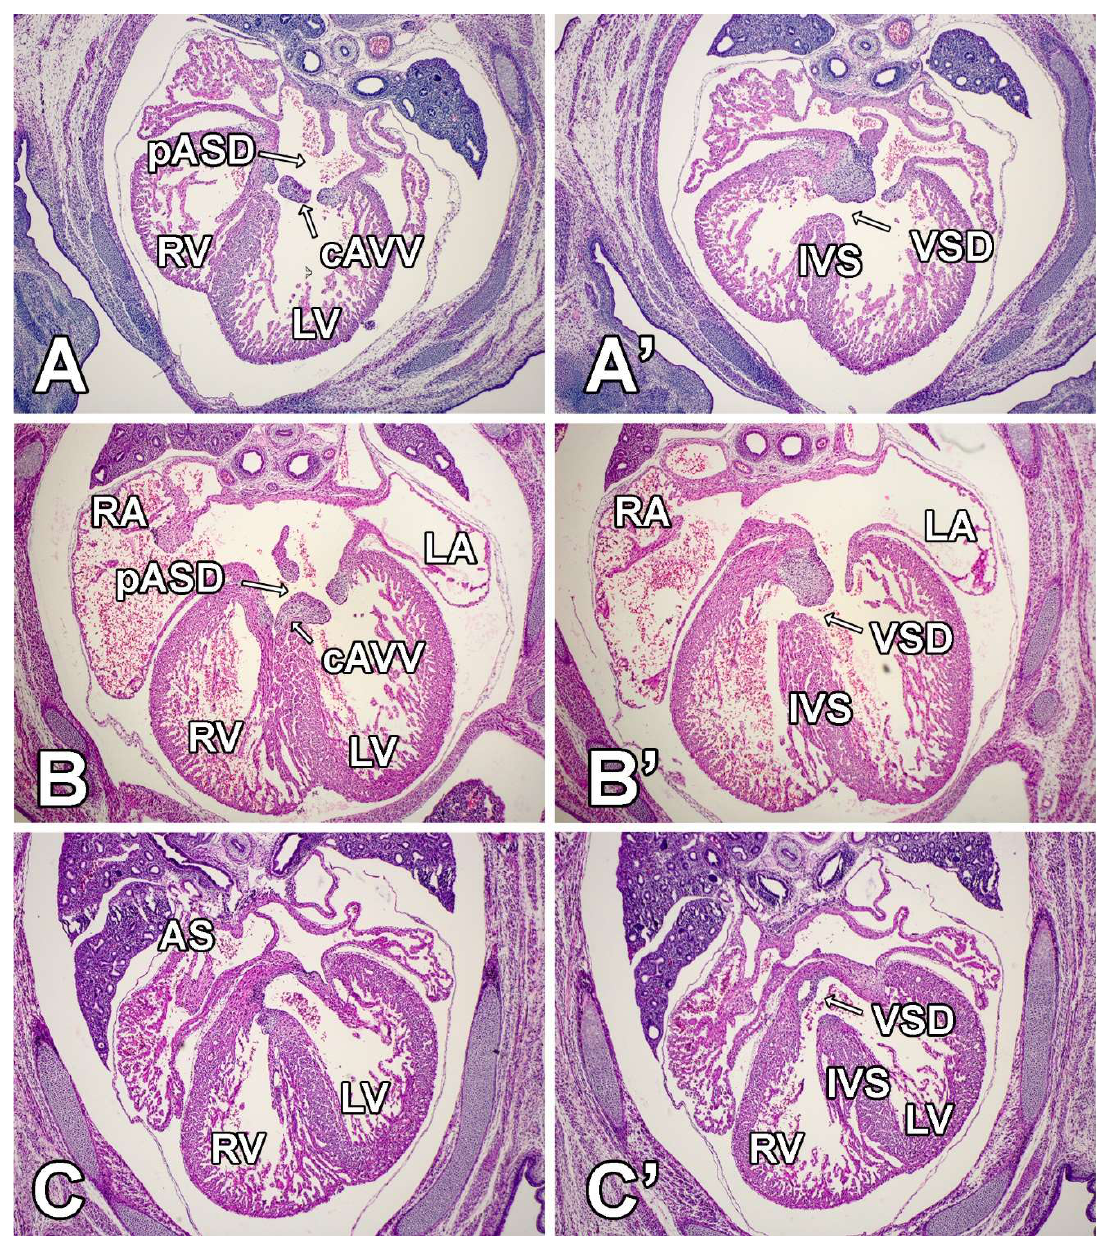
Figure 7. Deletion of Sox9 from the SHF results in atrial and ventricular septal defects. These panels show serial sections of three SHFcre;Sox9fl/fl embryos at ED14.5 ( A , A’ ), ED15 ( B , B’ ), and ED14.5 ( C , C’ ). ( A , A’ , B , B’ ) show examples of hearts with complete AVSD (primary ASD, common AVV, and inlet type VSD), whereas ( C , C’ ) shows a heart with an intact atrial septum ( C ) and an isolated subaortic VSD ( C’ ). AS = atrial septum, cAVV = common AV valve, IVS = interventricular septum, LA = left atrium, LV = left ventricle, pASD = primary atrial septal defect, RA = right atrium, RV = right ventricle, VSD = ventricular septal defect.